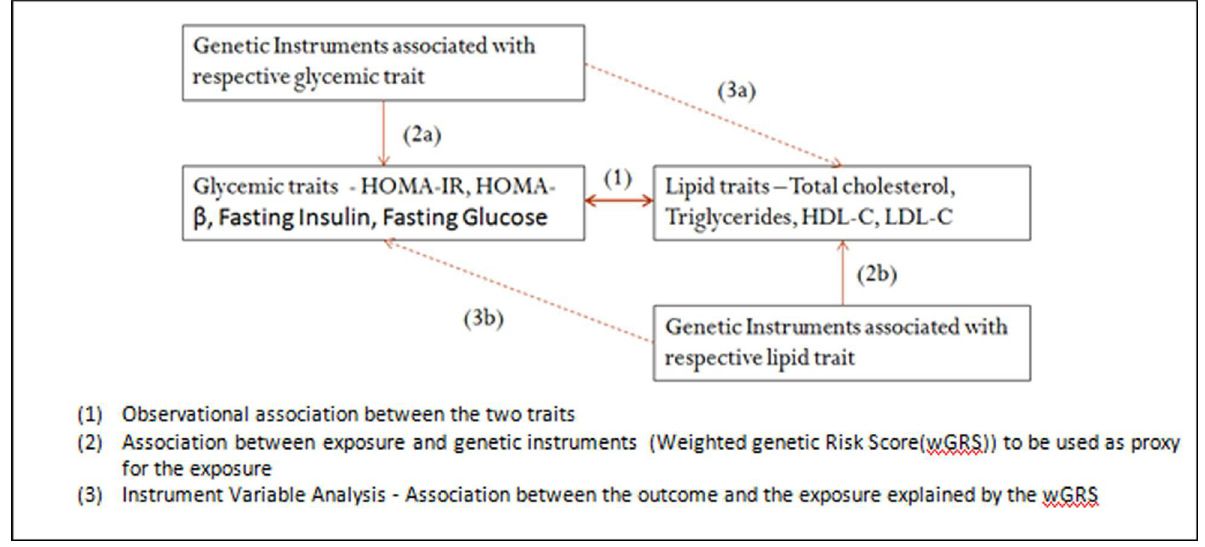
Fig 2. Pictorial explanation of the application of Bidirectional Mendelian Randomization in the present analyses.